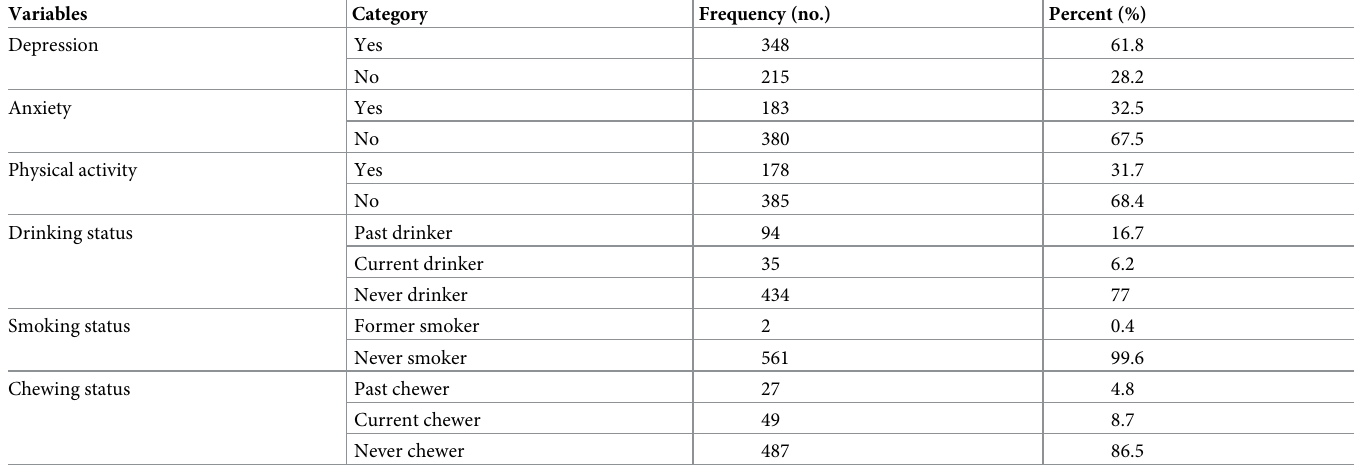
Table 3. Adult HTN patients’ psychosocial and behavioral characteristics at chronic follow-up care clinics in northwest Amhara regional state referral hospitals, Northwest Ethiopia, 2021 (n = 563).